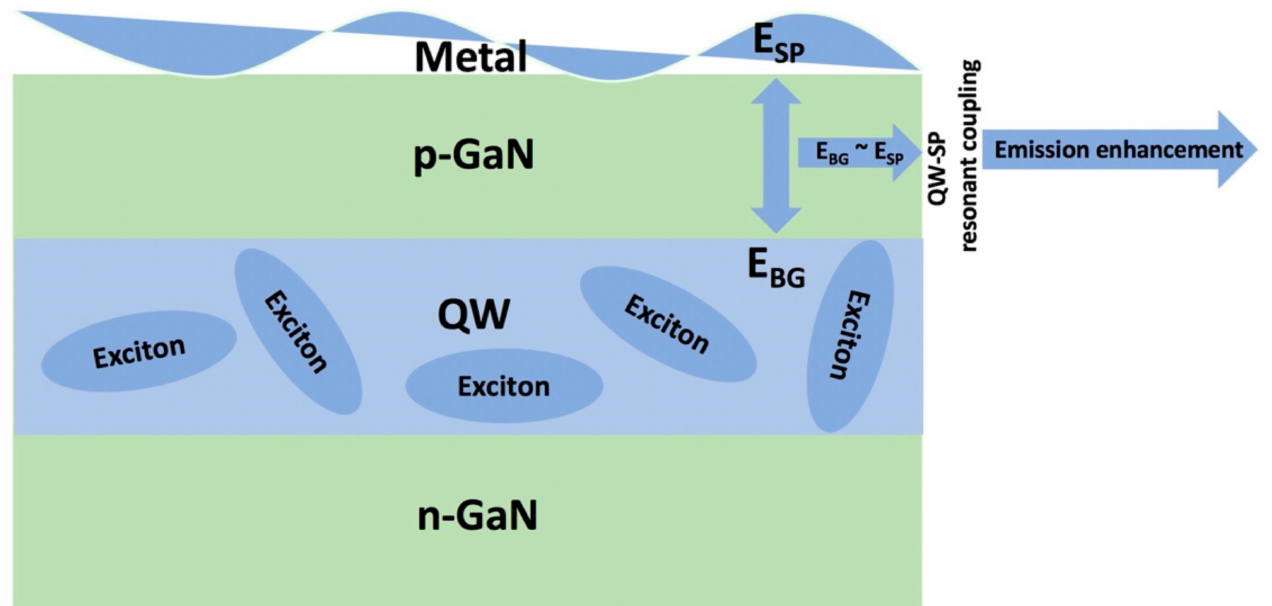
Figure 1. Schematic representation of SP–QW coupling